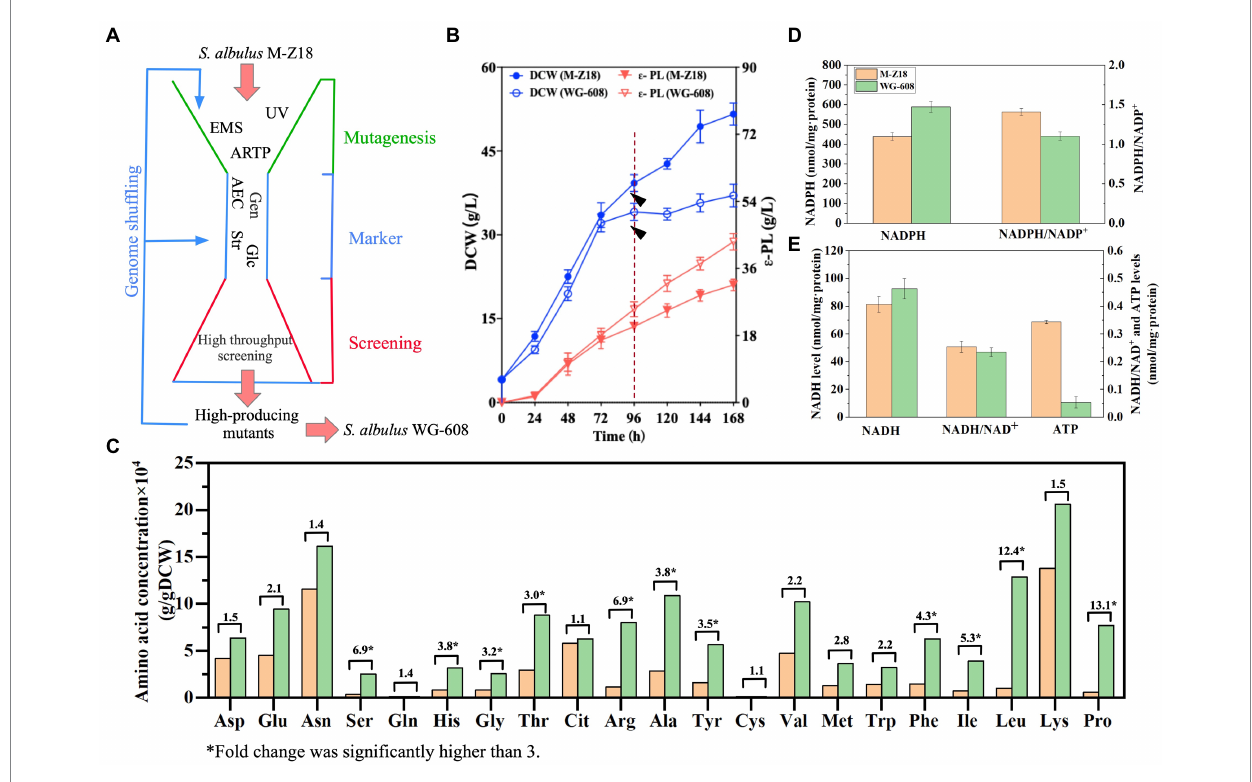
FIGURE 1 Comparison of the physiological characteristics between S. albulus M-Z18 and S. albulus WG-608. (A) Workflow for the S. albulus WG-608 bioengineering process. UV, ultraviolet mutagenesis; EMS, ethylmethylsulfone mutagenesis; ARTP, atmospheric and room temperature plasma; AEC, S-(2-aminoethyl)-L-cysteine; Str, Streptomycin; Gen, gentamycin; Glc; glucose; Asp., L-aspartate; Glu, L-glutamate; Asn, L-asparagine; Ser, L-serine; Gln, glutamine; His, L-histidine, Gly, L-glycine; Thr, L-threonine; Cit, Citrate; Arg, L-arginine; Ala, L-alanine; Tyr, L-tyrosine; Cys-s, L-cysteine; Val, L-valine; Met, L-methionine; Trp, L-tryptophan; Phe, L-phenylalanine; Ile, L-isoleucine; Leu, L-leucine; Lys, L-lysine; Pro, L-proline. (B) Dry cell weight and ε -PL production by S. albulus M-Z18 and S. albulus WG-608 in fed-batch fermentation. DCW, dry cell weight. (C) Intracellular amino acid levels at 96 h. Numbers above columns show fold difference and * indicates fold change was significantly higher than 3. (D) NADPH and NADPH/NADP + levels at 96 h (E) NADH, NADH/NAD + and ATP levels at 96